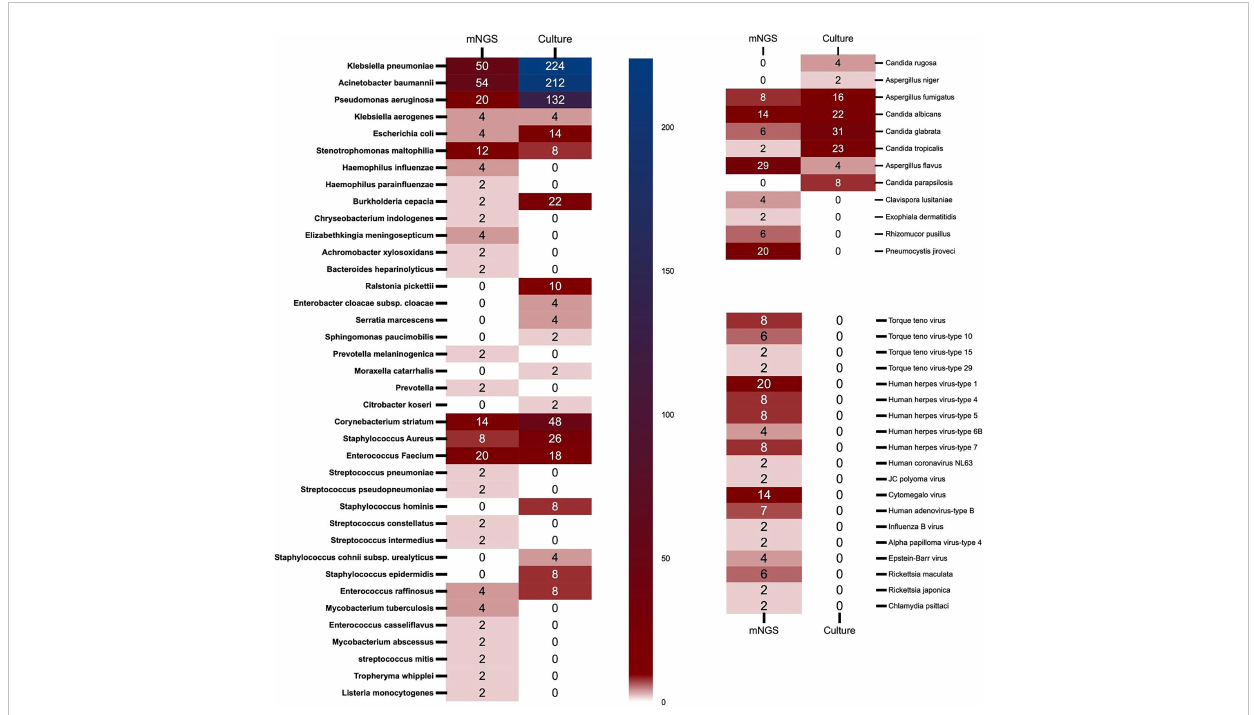
FIGURE 3 The heat map of pathogenic microorganisms details in different methods (mNGS and conventional culture). mNGS, metagenomic next-generation